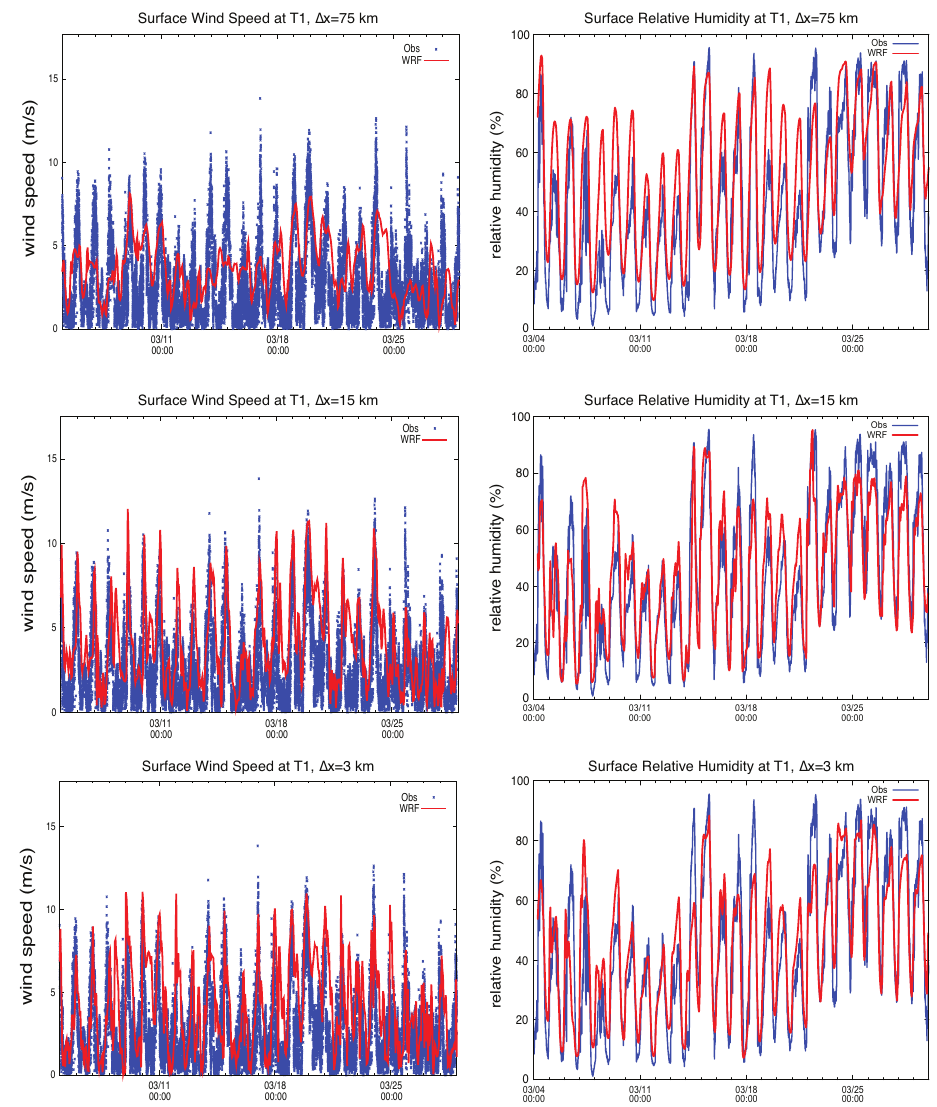
Fig. 4. Time series at site T1 of observed (blue) and simulated (red) wind speed (left column, unit: ms − 1 ) and relative humidity (right column, unit: %) for 75-km (top), 15-km (middle), and 3-km (bottom) simulations,